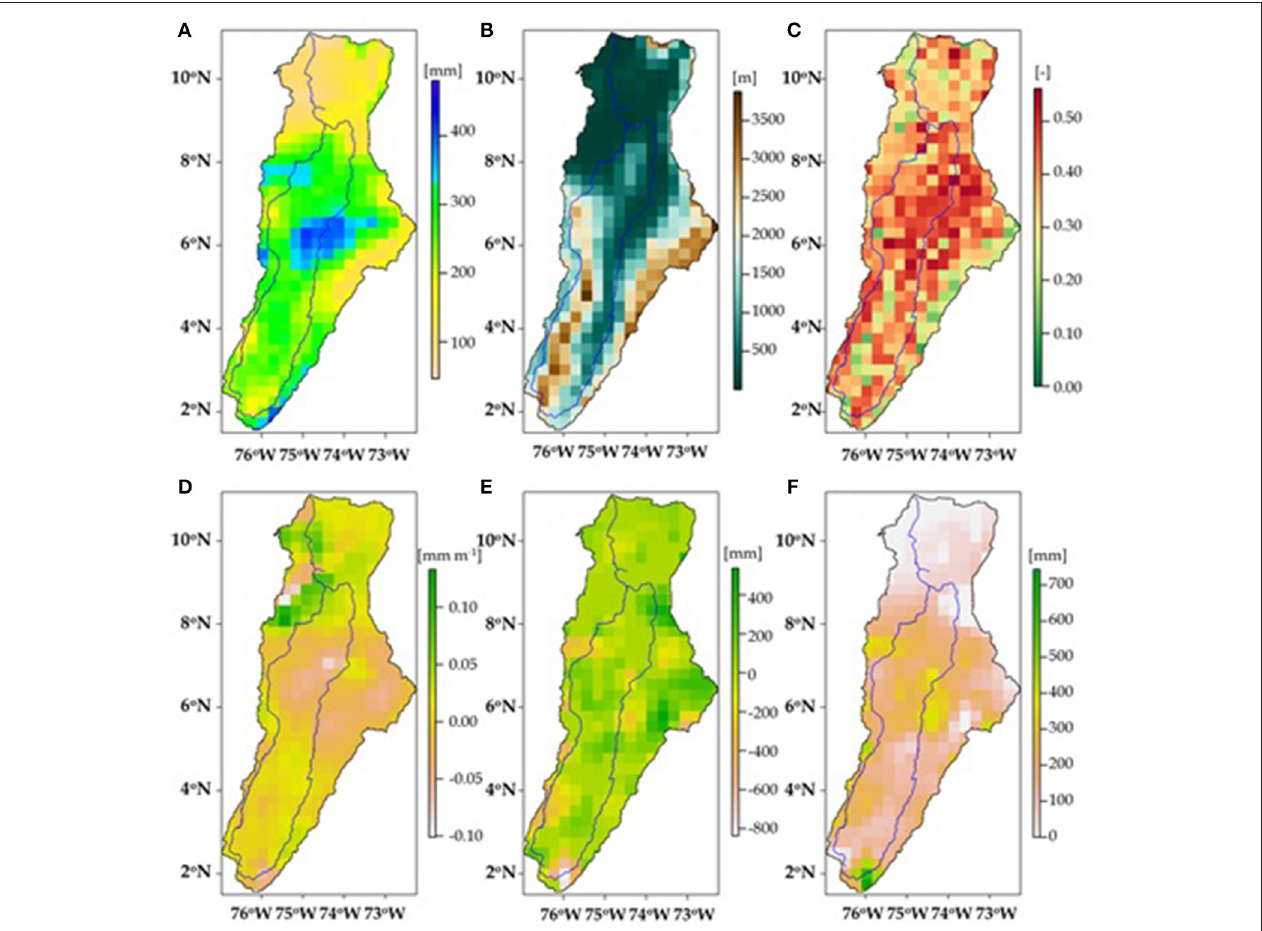
FIGURE 4 | Spatial distribution of (A) average monthly MSWEP precipitation, (B) DEM, (C) average monthly EVI, (D) GWR slope parameter for DEM, (E) GWR slope parameter for EVI, and (F) GWR intercept in May 2003 at 25km